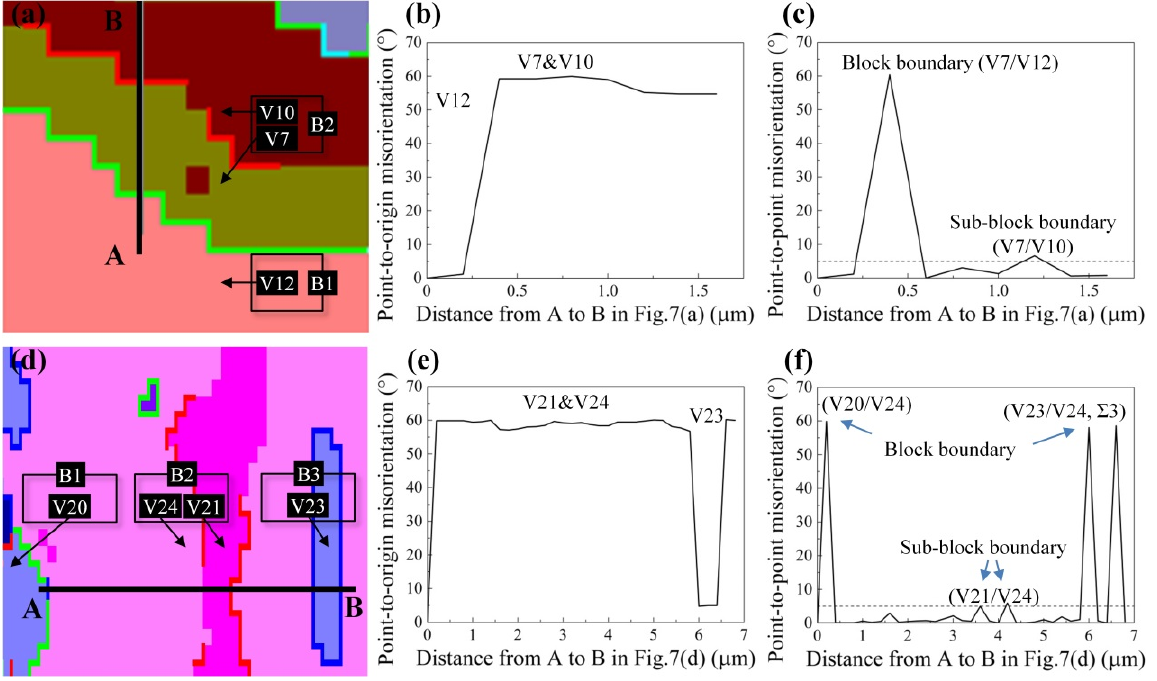
Figure 7. Variant pairing of the selected regions from GB maps, the point-to-origin misorientation and the point-to-point misorientation profile from A to B: ( a – c ) IT698 and ( d – f ) IT673. Grain boundaries are colored in: red, LAGBs; blue, Σ 3 boundaries; green, other HAGBs. Black arrows indicate variants and blue arrows indicate the types of boundary. (V1: variant 1, . . . V24: variant 24. B1: block 1; . . . B3: block